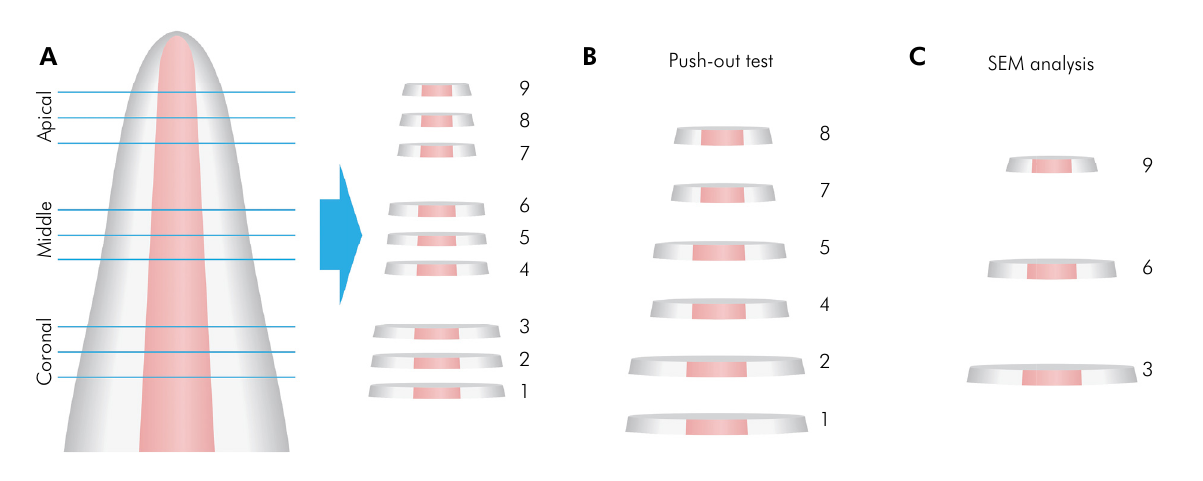
Figure 1. Schematic drawing of the collection and distribution of root slices. (A) Nine 1-mm-thick slices (3 per third) were obtained from each root sample. (B) The first and second slices in each root third were subjected to push-out tests. (C) The other slices in each root third were analyzed by